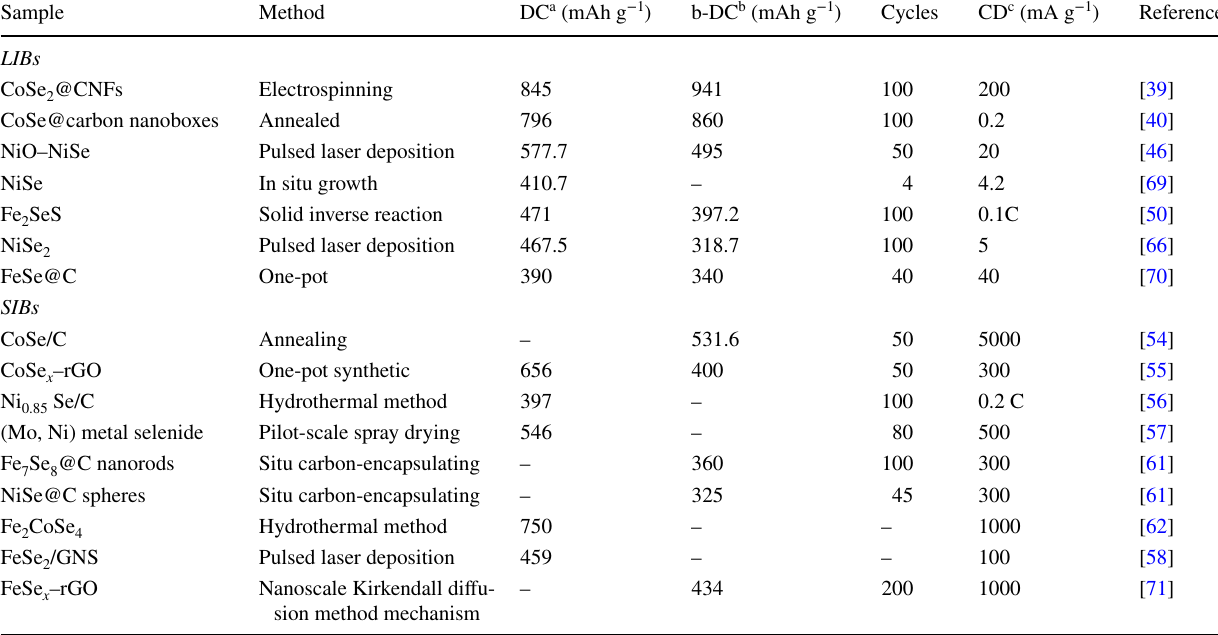
Table 1 Application of iron/cobalt/nickel selenides in LIBs and SIBs